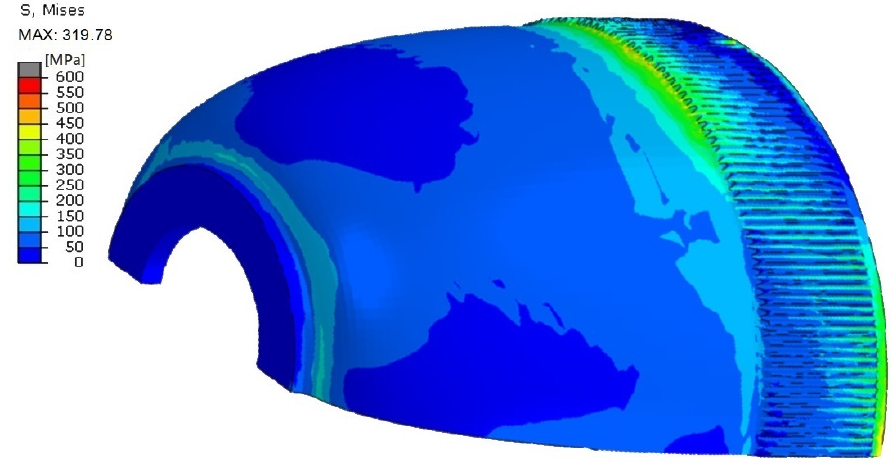
Figure 11. The distribution of the stresses in the flexspline model—variant VII.